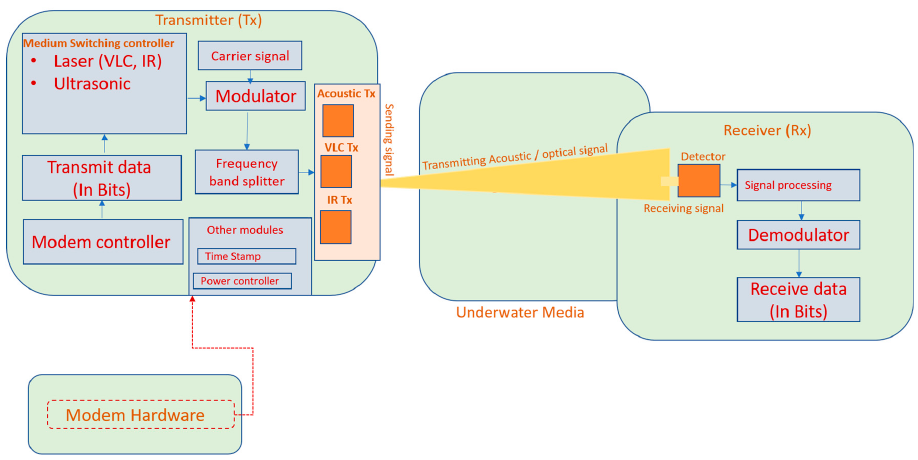
Figure 5 . Physical layer components and workflow. Figure 5. Physical layer components and